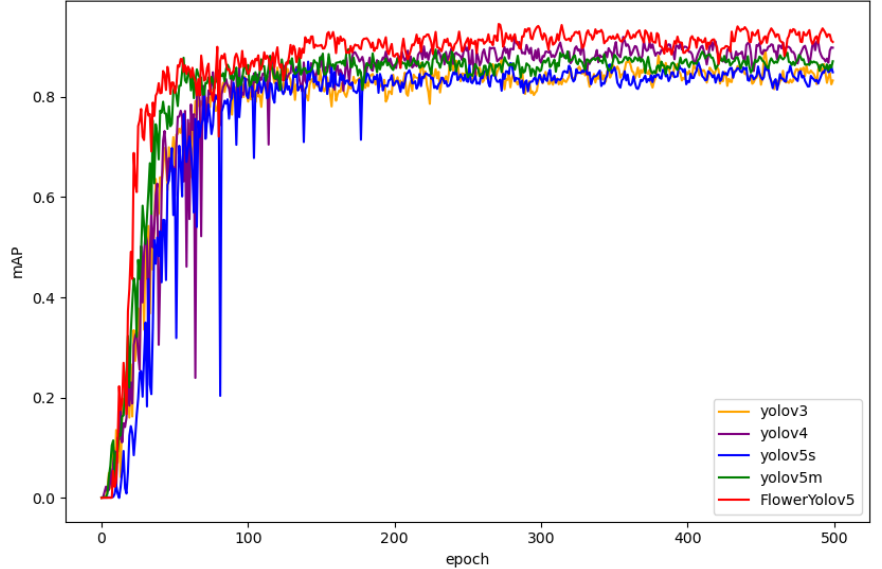
Figure 7. mAP curves of the five object detection models.